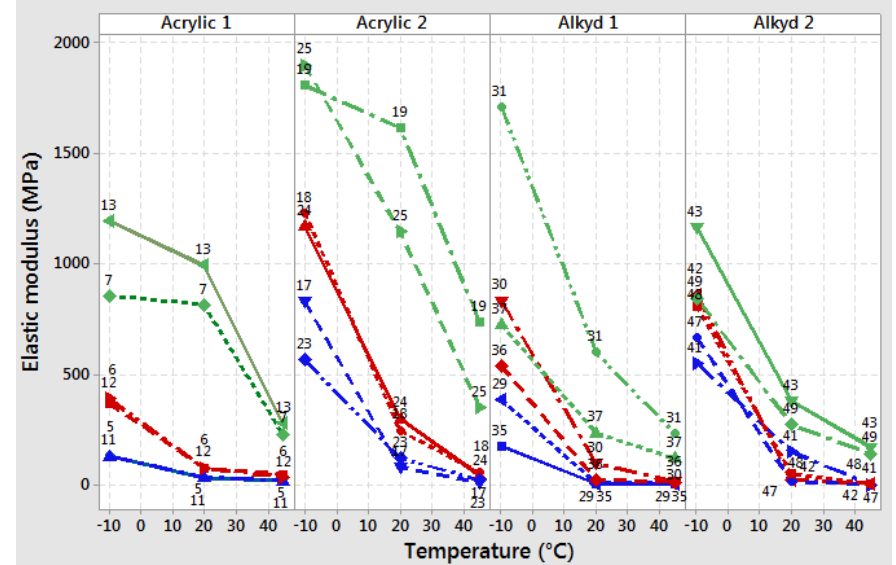
Figure 4. Influence of coating formulation on elastic modulus for the three test temperatures (in blue: clear PVC; in red: low PVC; in green: high PVC).